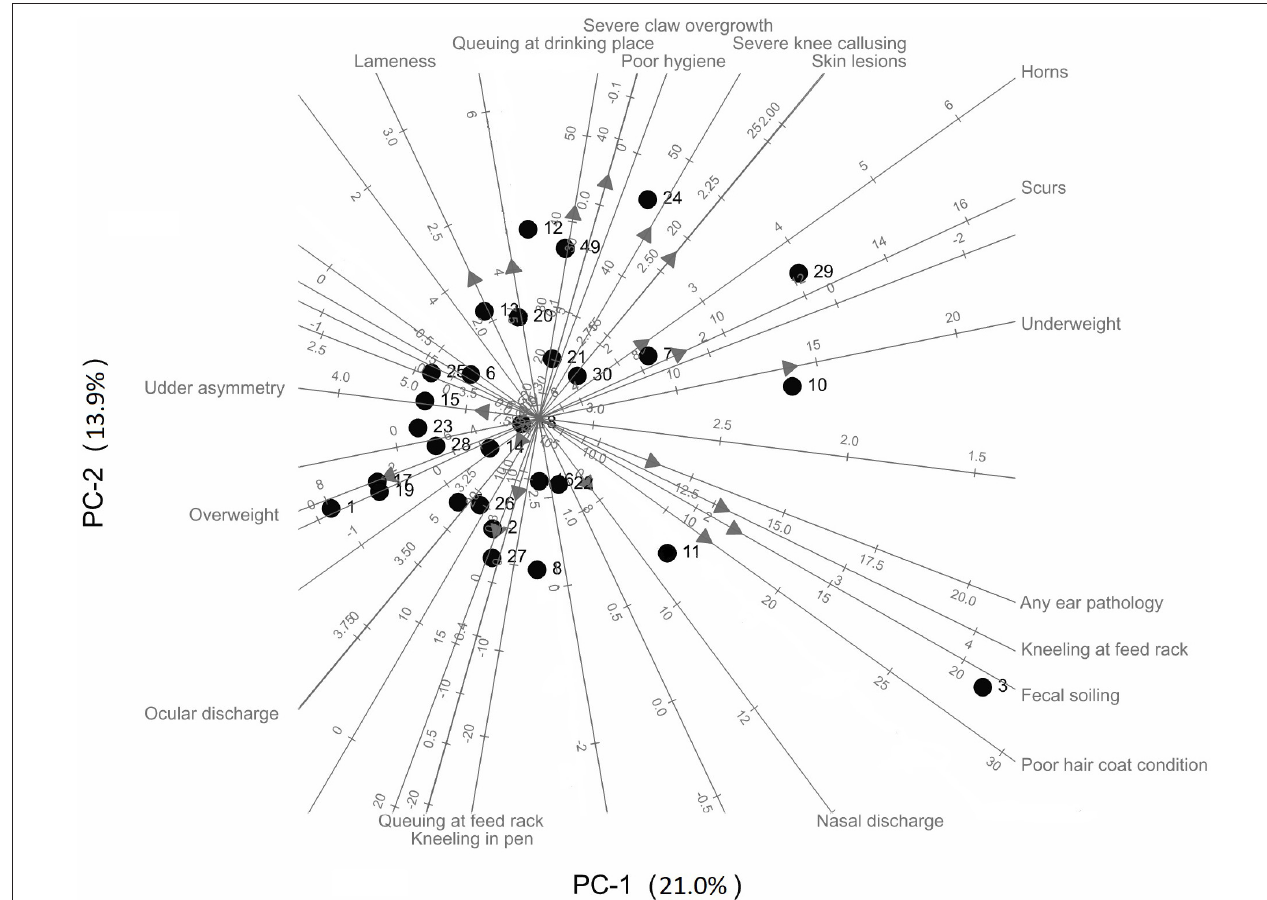
FIGURE 1 | Principal components biplot of welfare indicators of dairy goats across 30 farms in the Midwestern United